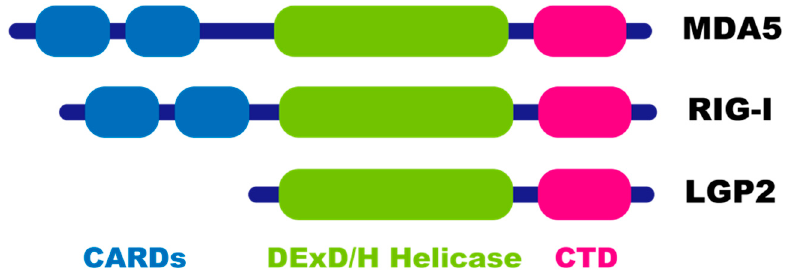
Figure 3. Structural representation of retinoic acid-inducible gene I (RIG-I)-like receptor family members. Melanoma differentiation-associated protein 5 (MDA5) and RIG-I comprise two caspase activation and recruitment domains (CARDs; shown in blue), which mediate signal transduction through interaction with the mitochondrial antiviral-signaling protein (MAVS), with a DExD/H-box RNA helicase domain (light green) and a C-terminal domain (CTD; shown in pink), both of which are required for RNA binding. LGP2 lacks CARDs.